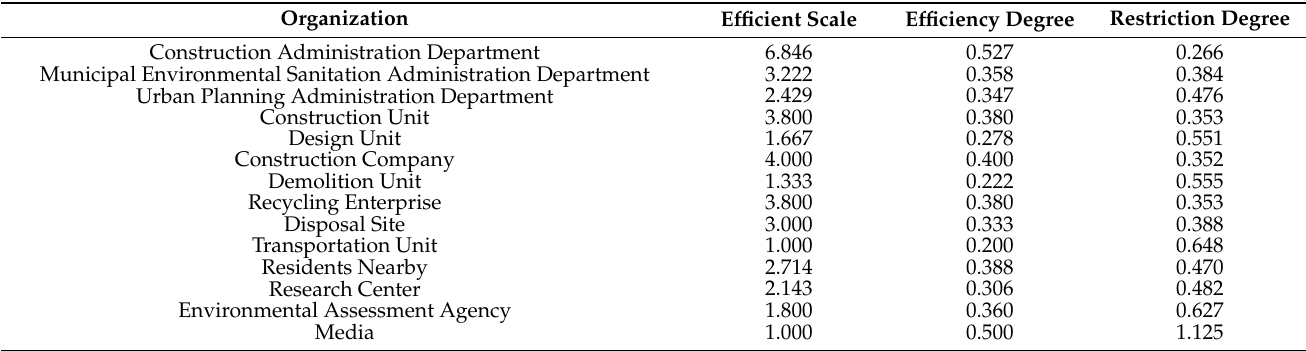
Table 8. Analysis on Structural Holes of